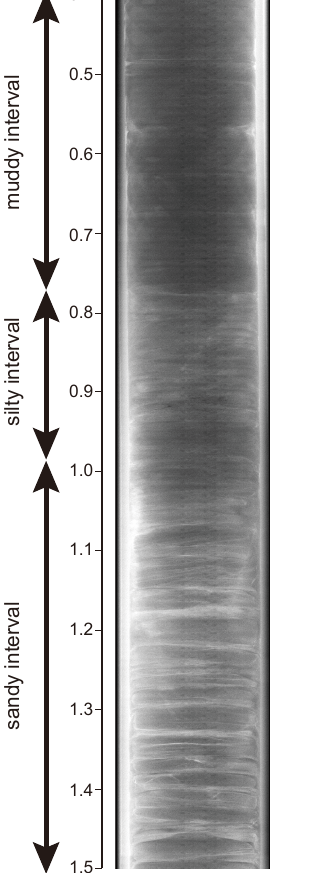
Figure 3. X-ray image of core C9004C-1P at full pressure in PCATS shows mud clast and methane hydrate veins in a matrix of hemipelagic mud.